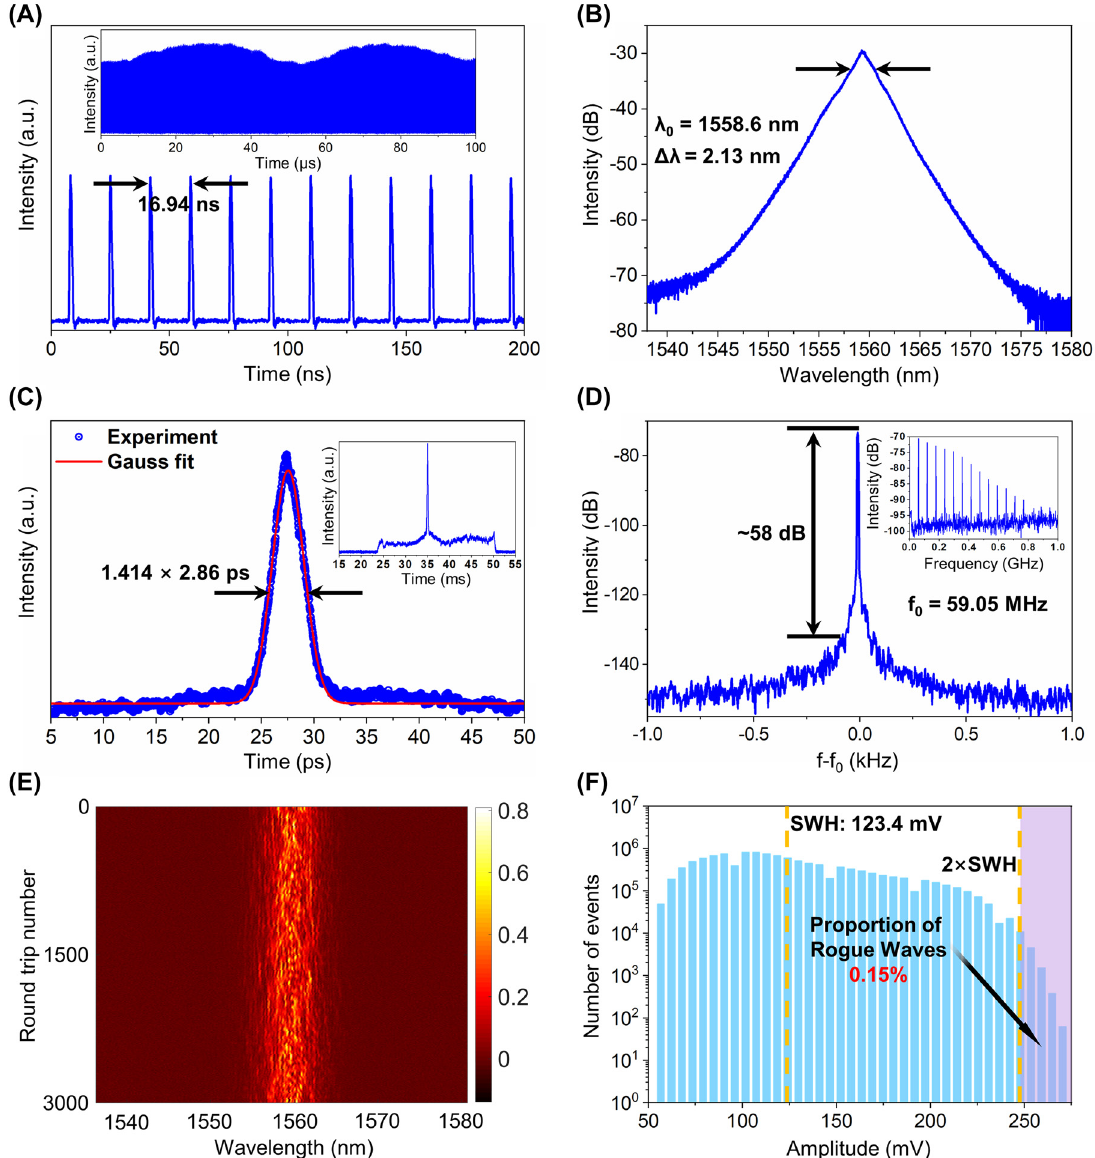
Figure 7: Noise-like mode-locked EDFL. (A) Oscilloscope trace; (inset: 100 μ s pulse trains); (B) optical spectrum; (C) autocorrelation trace; (D) RF spectrum with 1 Hz resolution in the range of 2 kHz (inset: RF spectrum with 100 kHz resolution in the range of 1 GHz); (E) spectral evolution; (F) intensity histograms of noise-like